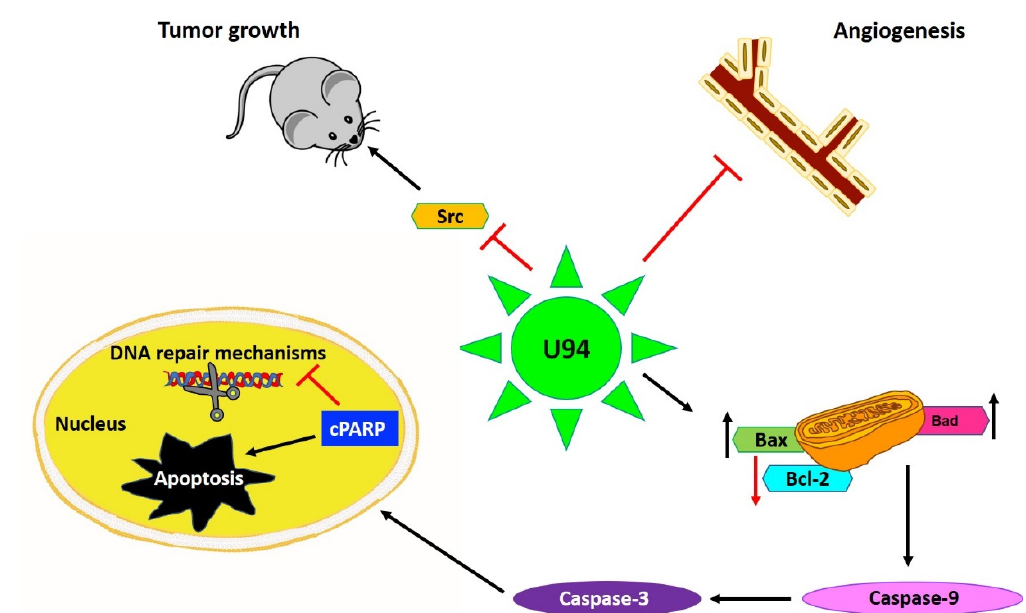
Figure 2. U94 regulates different mechanisms to exert its activities mainly by downregulation of proto-oncogene Src, resulting in inhibition of cancer cell proliferation both in vitro and in vivo. Secondly, U94 was found to suppress angiogenesis ex vivo by suppressing the vessel formation. The viral protein upregulates pro-apoptotic genes like Bax and Bad levels and downregulates anti-apoptotic Bcl-2 levels culminating in Caspase-9 activation. Finally, the cleavage of Poly (ADP-ribose) polymerase (PARP) results in inhibition of DNA repair and mediation of intrinsic apoptosis in cancer cells. Upward arrow ↑ —upregulation; downward arrow ↓ —downregulation.